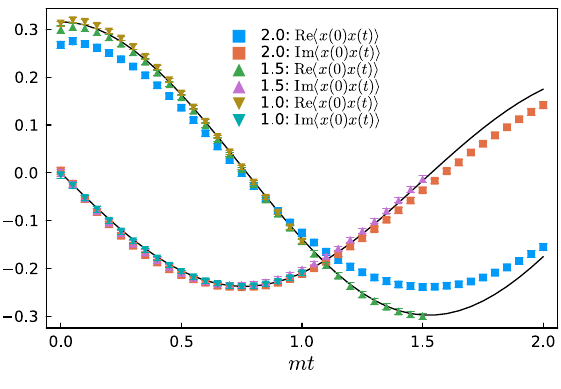
Figure 8 . A detailed comparison of the unequal time correlation functions h x (0) x ( t ) i from figure 7 evaluated in the presence of the optimal learned field-independent kernel on contours with mt 1 , 1 . 5 and 2 respectively.The different colored circles correspond to the real-part while the squares to the imaginary part of the correlator. Values of the correlators from the solution of the Schrödinger equation are given as solid black lines.